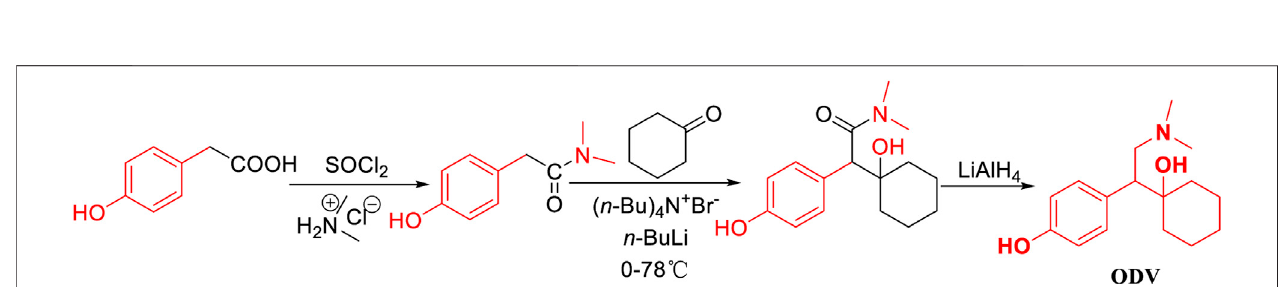
FIGURE 1 | The synthesis of desvenlafaxine catalyzed by Li[sec-butyl] 3 BH.